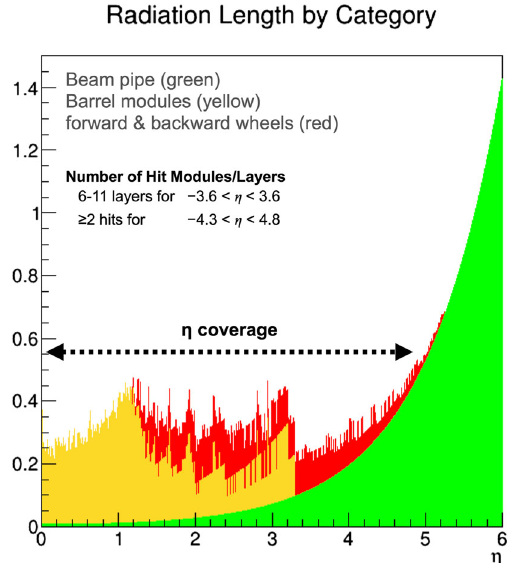
angle scattered electron to tag γ p and γ A collisions and forward detectors for neutrals ( n , π 0 …) from the p / A rem- nant and protons spectrometer to measure proton momentum from elastic and quasi-elastic scattering.